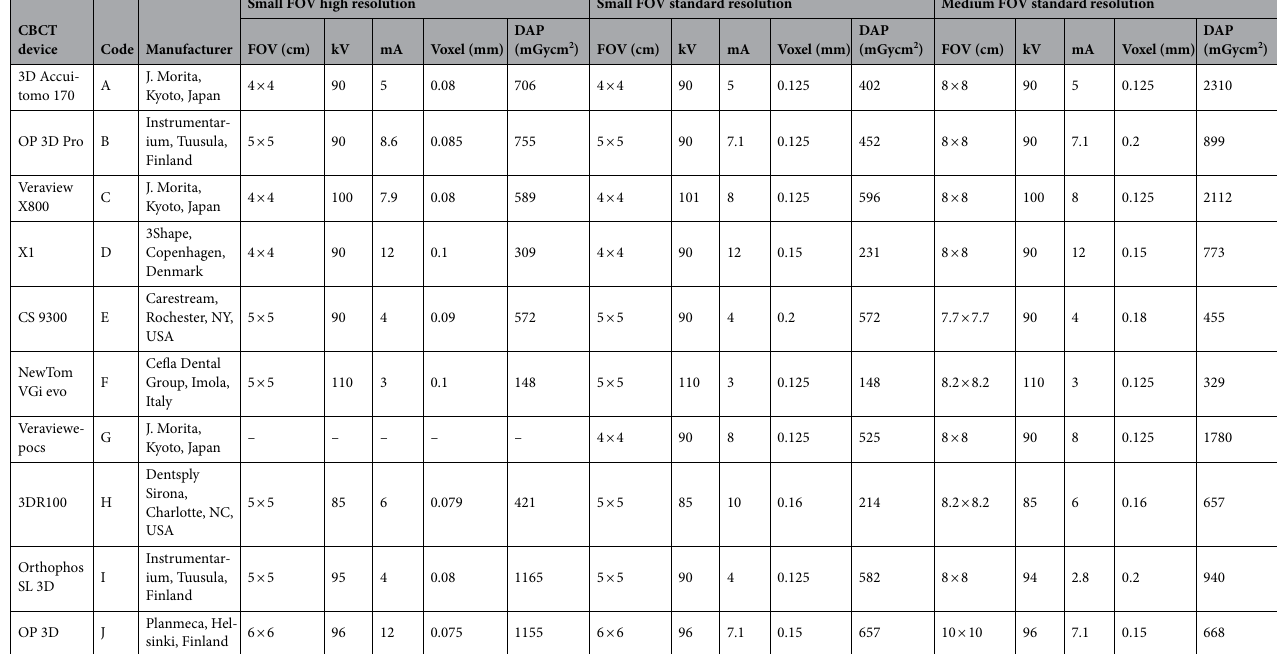
Table 1. Detailed description of the CBCT devices, manufacturers, codes, and scanning protocols used in the present study. FOV field of view, DAP dose-area product indicated by the